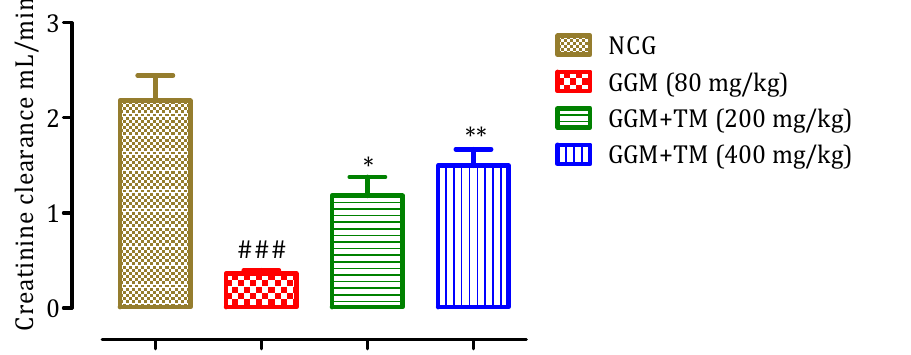
Figure 4. Effect of APTM on creatinine clearance in GM-intoxicated rats. Data are expressed as means ± SEM, (n = 6). ### p < 0.001 related to NCG. * p < 0.05, ** p < 0.01 compared to GGM (80 mg/kg, b.w).